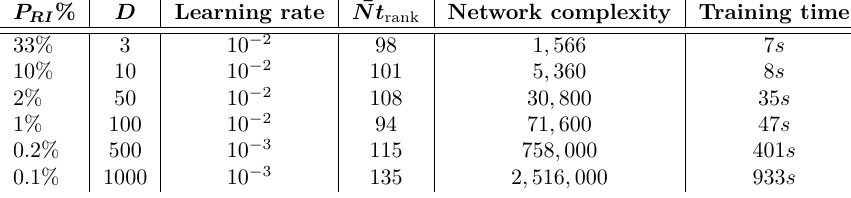
Table 1: Impact of the trace dimension on the cVAE-SA performance (with s = 1, N v = 10, batch-size =